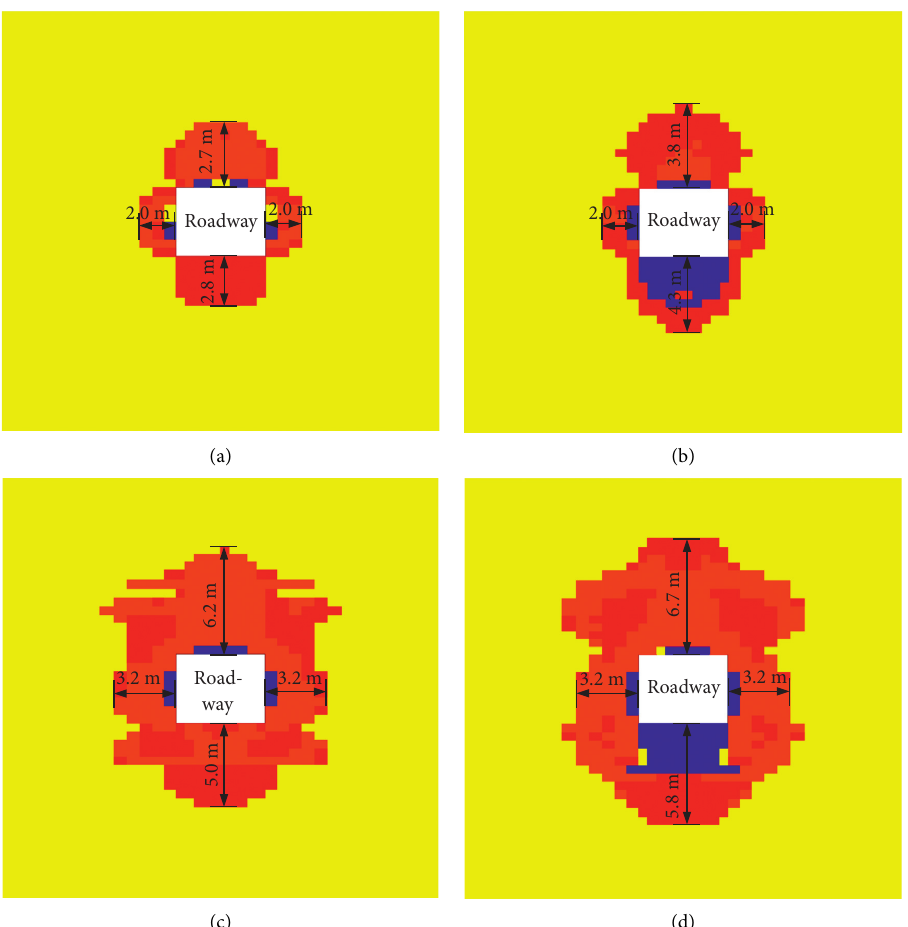
Figure 10: Distribution of plastic zone of weakly cemented soft rock roadway surrounding rock under different simulation schemes (red: shear failure, blue: shear-tension failure). (a) Scheme 1: without softening and expansion. (b) Scheme 2: with expansion. (c) Scheme 3: with softening. (d) Scheme 4: with softening and